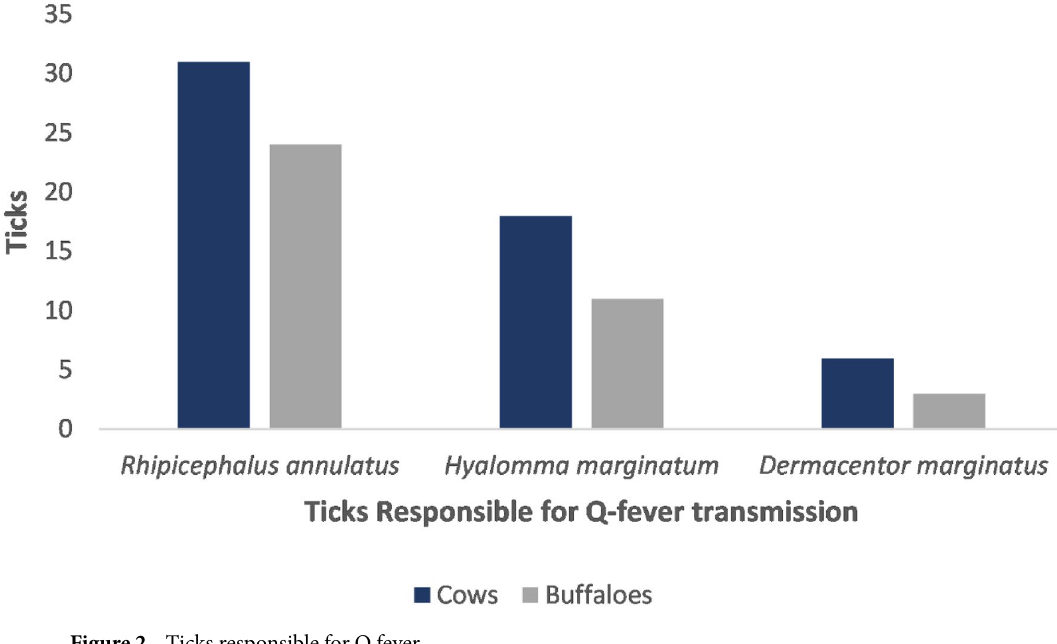
Figure 2. Ticks responsible for Q